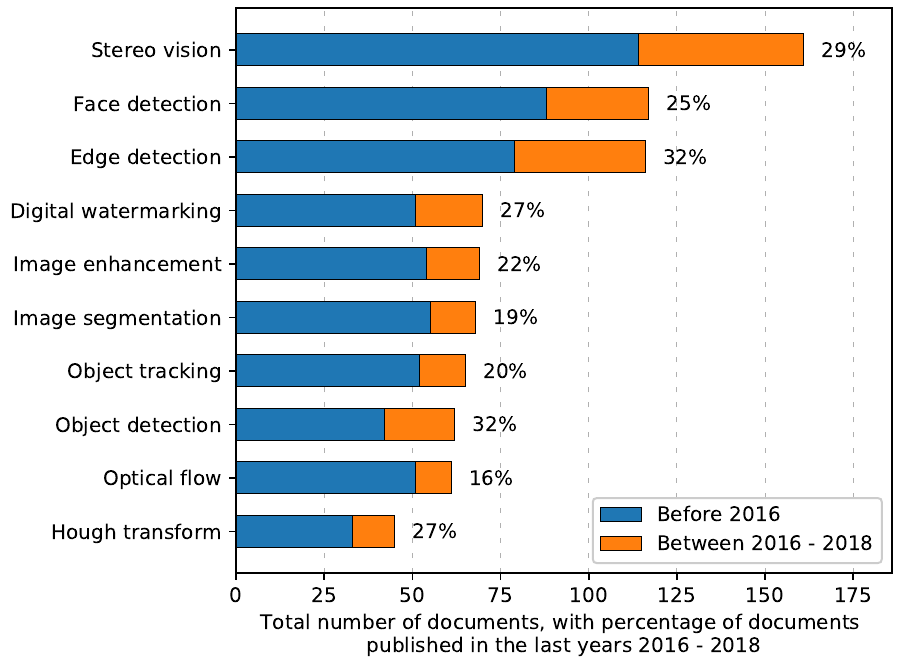
Figure 12. Image and video compressing processing top techniques implementations in FPGA